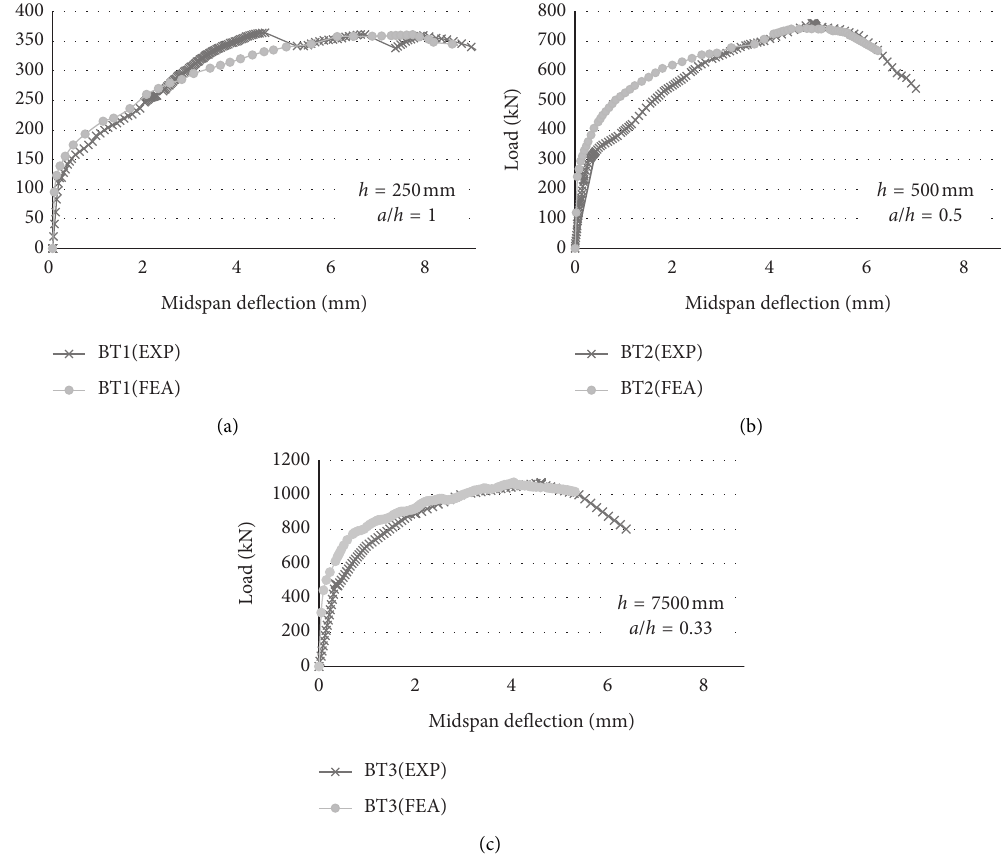
Figure 7: FE versus experimental load-deflection diagrams. (a) BT1. (b) BT2. (c)